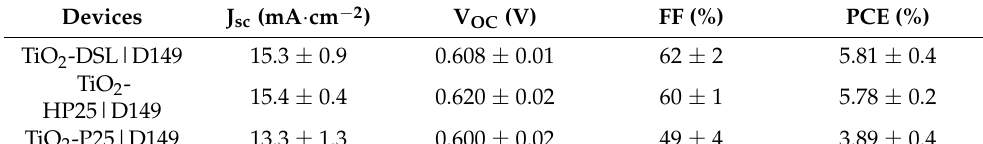
Table 2. Photovoltaic measurements of TiO 2 -DSL|D149, TiO 2 -HP25|D149, and TiO 2 -P25|D149 devices.